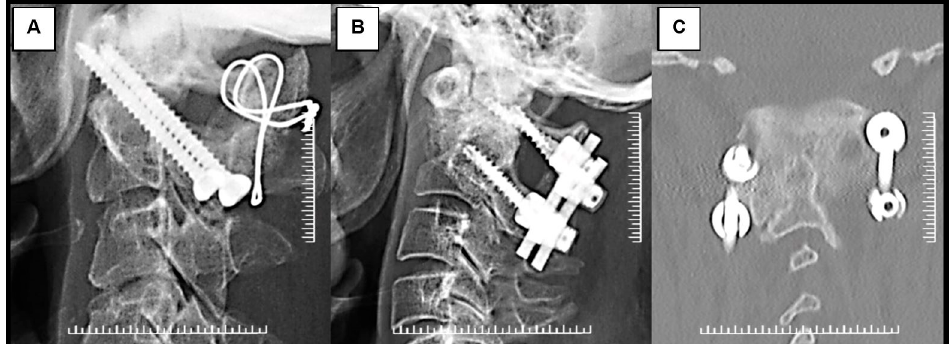
Figure 3. Radiographic images of patients with reducible nonunited type II odontoid fracture with myelopathy treated with ( A ) Magerl’s C1-C2 transarticular screw fixation technique augmented with supplemental wiring and ( B ) Harms-Goel C1-C2 screw-rod segmental fixation technique. Coronal CT scan imaging ( C ) shows C1-C2 complex screw construction with solid fusion mass in Harms-Goel C1-C2 screw-rod segmental fixation technique at 3-month follow-up.